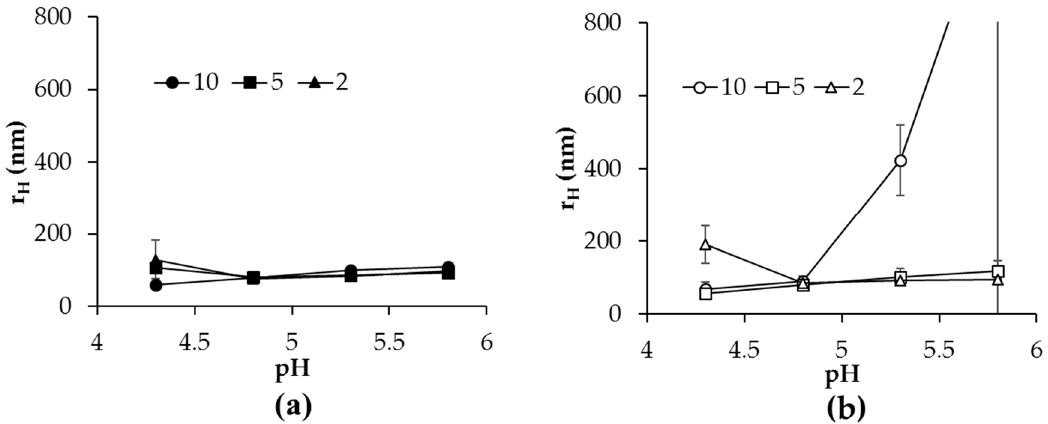
Figure 3. Effect of pH and r -value on hydrodynamic radii of heated α -lac mixtures with ( a ) CH 113 or ( b ) CH 113 PEG.